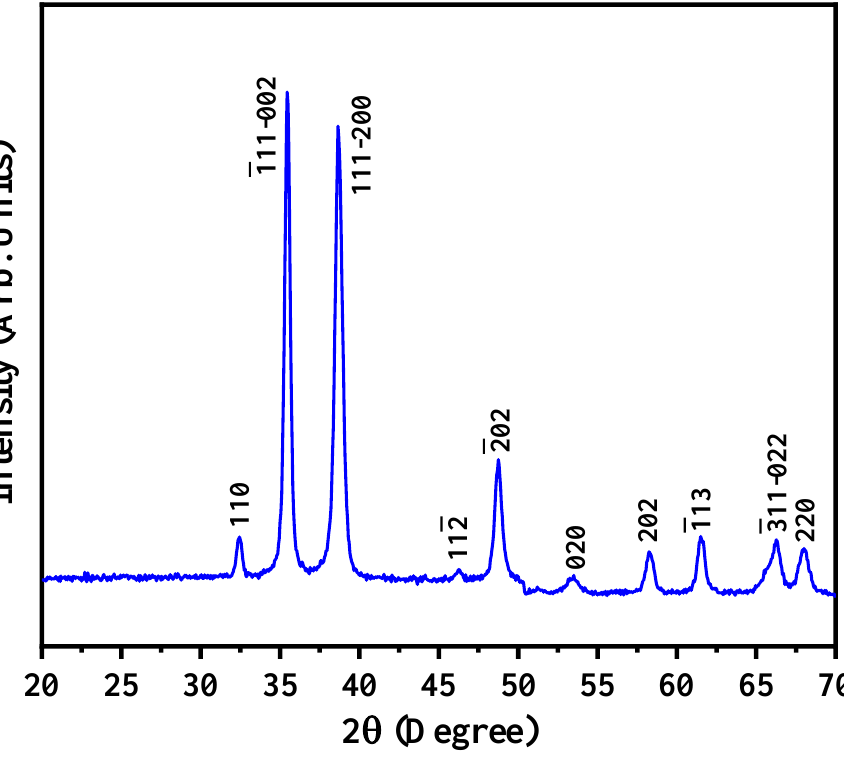
Figure 3. XRD patterns of hydrothermally synthesized leaf-shaped CuO nanosheets. The crystal size (d) of the leaf-shaped CuO with monoclinic crystalline phase was determined by using Debye-Scherrer equation (Equation (2)).